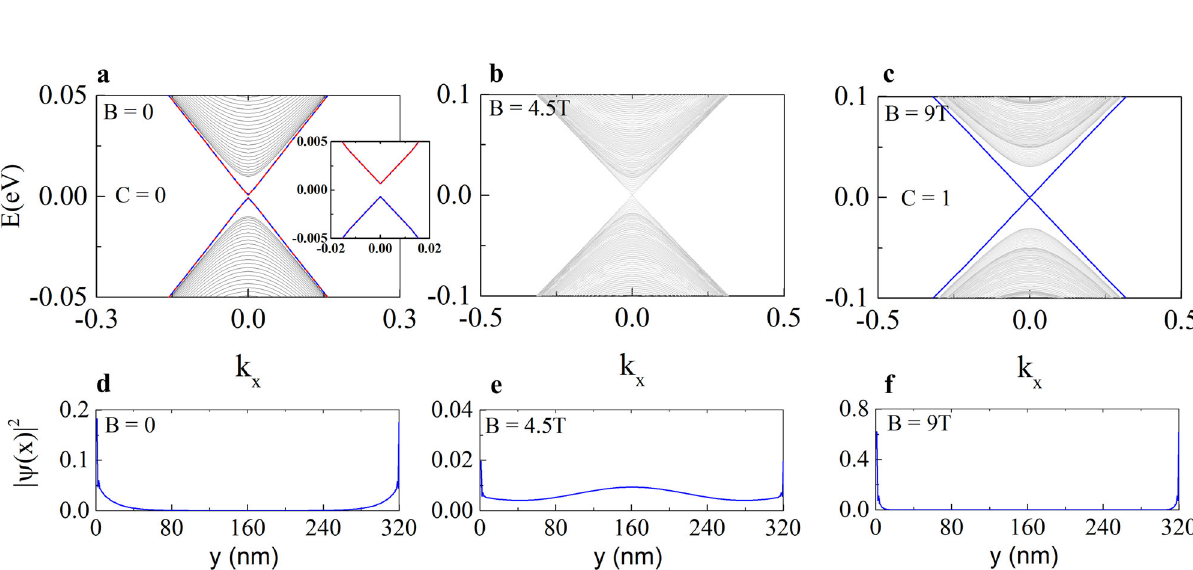
distributions of the typical wave functions along y direction at E=0 : 006eV for different B . The model parameters are M z =0 : 04eV, A 2 =2eV ∙ Å, B 2 =24eV ∙ Å 2 , m : 116 eV, A : 1964 eV ∙ Å, and B : 4048 eV ∙ Å 2 0 =0 1 =3 1 =9